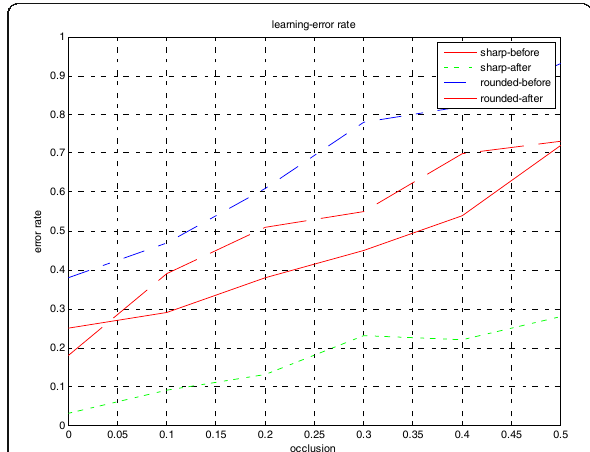
Fig. 10 Error rates affected by the learning